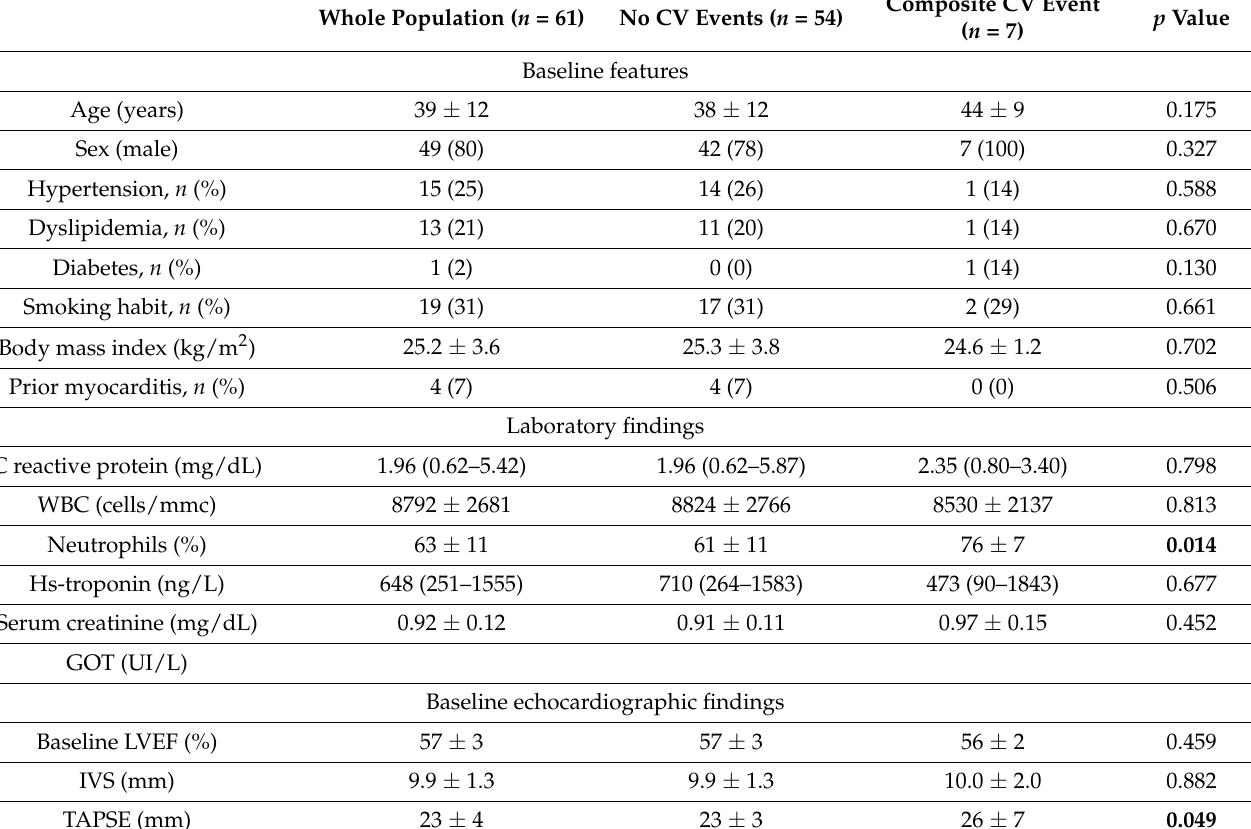
Table 1. Descriptive analysis of our population of patients with acute myocarditis and preserved ejection fraction, divided according to cardiovascular (CV) events at follow-up. Significant p values are reported in